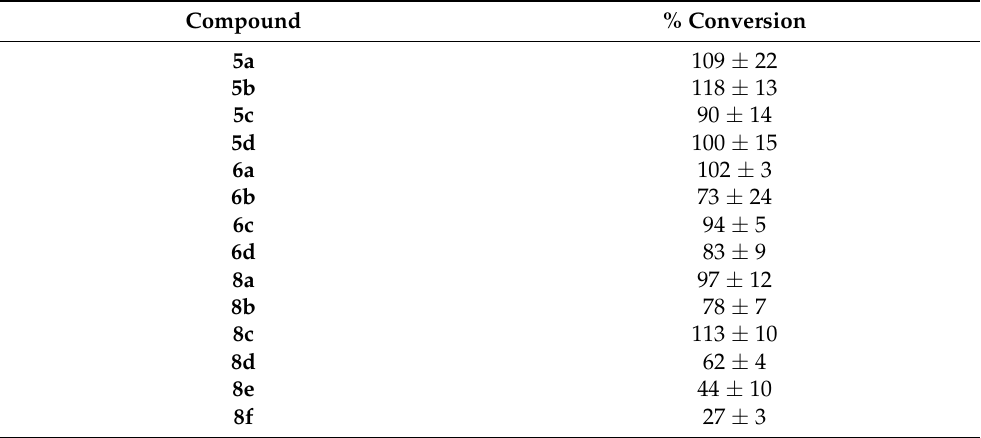
Table 1. Compound screening according to RT-QuIC percentage of PrP conversion ± Standard error.